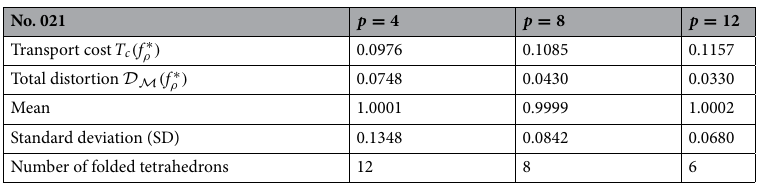
Table 1. No. 021: transport cost T c ( f ∗ ρ ) of (3), total mass-measure distortion D M ( f ∗ ρ ) of (10), mean, SD and 4, 8 and 12, number of folded tetrahedrons for p =